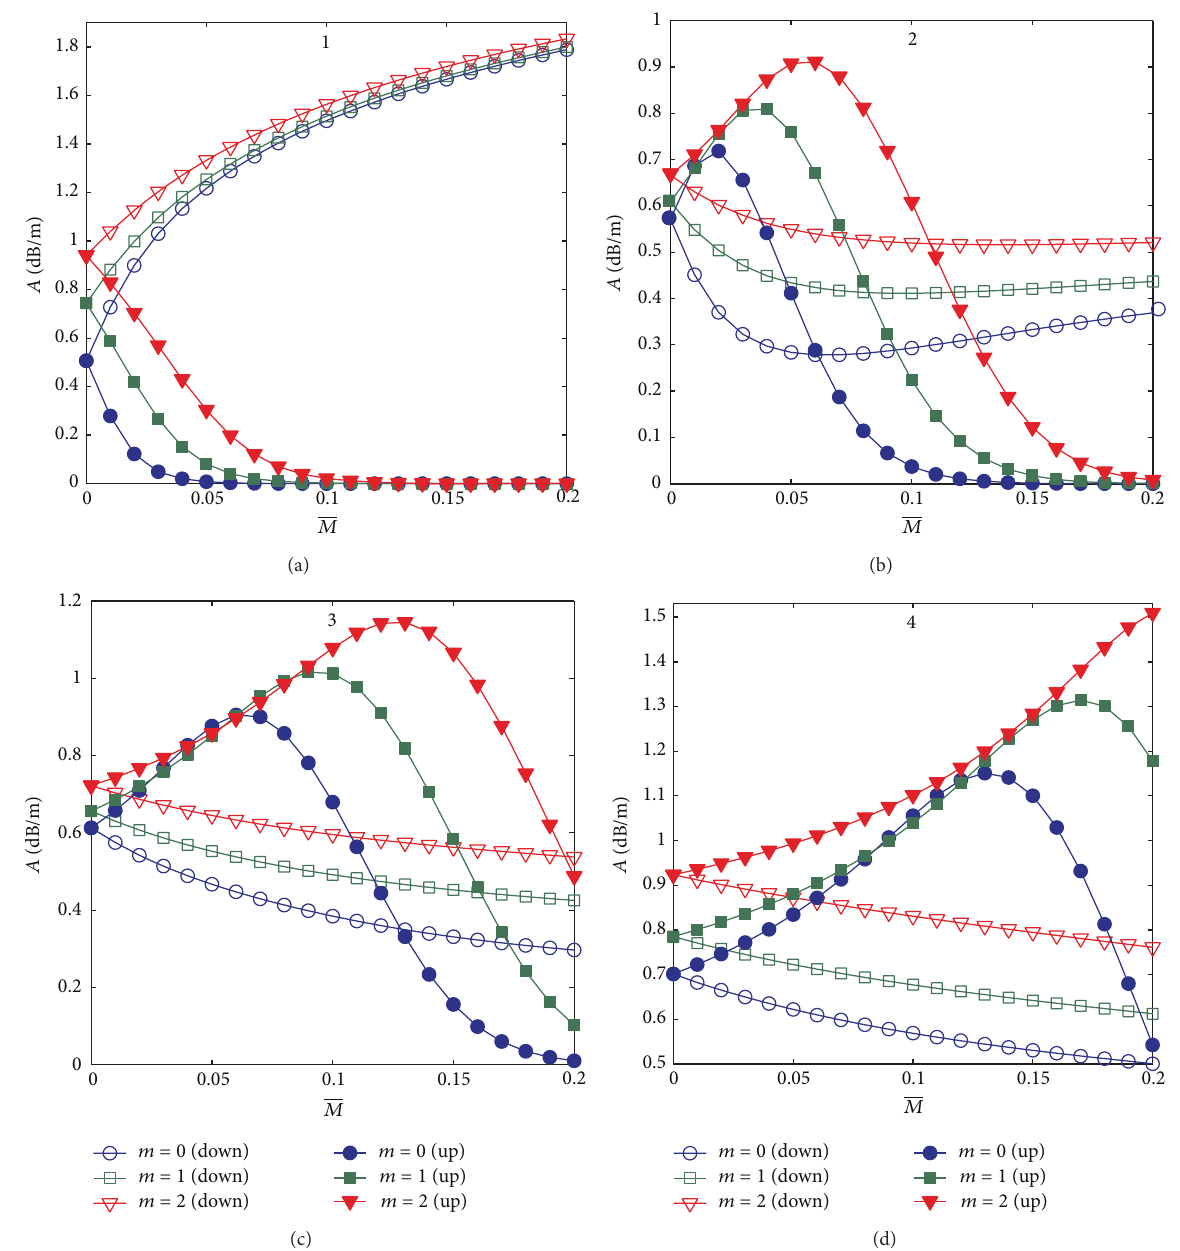
Figure 7: (Color online) Comparison of the attenuation coefficients of the first four axial pseudo-modes among the three circumferential modes in the laminar flow confined by a lined-walled